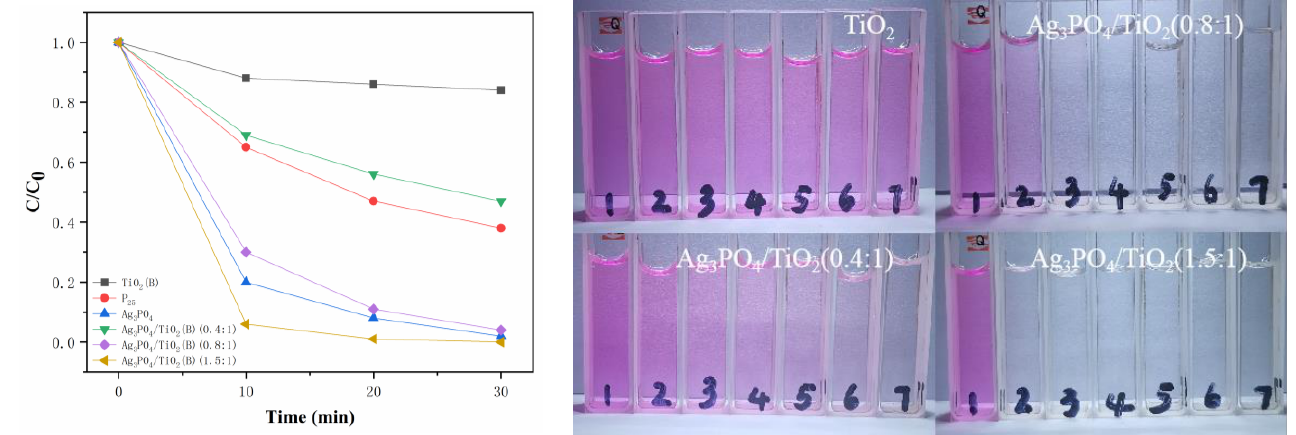
Figure 5. Photocatalytic degradation curves and images of Ag 3 PO 4 /TiO 2 composite.